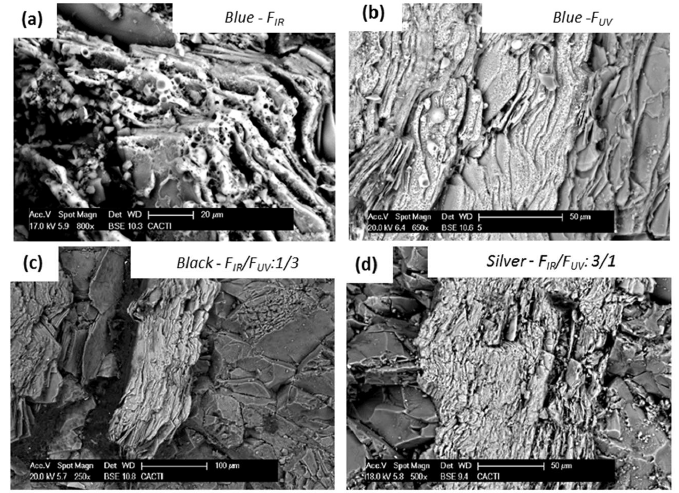
Figure 8. SEM micrographs of biotite grains on some areas treated with the selected conditions to extract blue ( a , b ), black ( c ) and silver ( d ) graffiti. ( a , b ) show melted biotite grains and ( c , d ) intact biotite grains. Detailed information on fluence values and pulses for each irradiation condition can be found in Table 2.